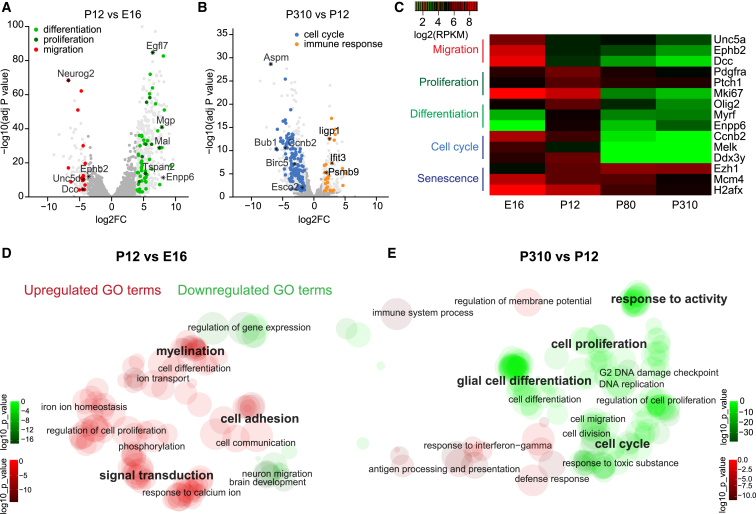
OPC Molecular Signatures Change with Age(A) Volcano plot showing differential expression of significantly altered genes for P12 compared with E16. Light gray circles indicate genes that are more than 4-fold increased between P12 and E16. Significantly altered gene ontology (GO) terms are highlighted (red, migration; dark green, proliferation; light green, differentiation). ∗selected genes of interest.(B) As for (A) but for P310 compared with P12; all circles denote significantly altered genes. Light gray circles represent genes that are more than 1.5-fold increased. A selection of significantly altered GO terms are highlighted (blue, cell cycle; orange, immune response). ∗selected genes of interest.(C) Heatmap of genes related to migration, proliferation, differentiation, cell cycle, and senescence across ages. Reads per kilobase million (log2(RPKM)) are plotted.(D) REVIGO semantic clustering visualization of GO analysis, showing all significantly altered terms at P12 compared with E16. The circle size approximately represents the number of genes within a GO term; the color intensity reflects the log10 p value. GO terms of particular interest are highlighted.(E) As for (D) but showing the GO terms at P310 compared with P12.